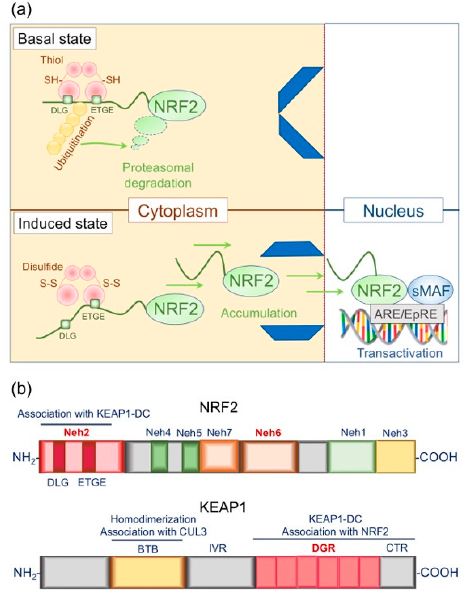
Figure 4. The structural and functional basis of the KEAP1/NRF2 signaling pathway. ( a ) The basics of the KEAP1/NRF2 signaling pathway. In the basal state, NRF2 is subjected to constant ubiquitin-proteasome-mediated proteolysis. NRF2 forms a cytosolic complex with KEAP1 via the DLG and ETGE motifs. In the induced state, modification of cysteine residues in KEAP1 causes a conformational change and liberates NRF2 from constant degradation, leading to nuclear accumulation and transactivation. ( b ) Schematic representation of the primary structure of NRF2 and KEAP1. Representative functions are indicated.